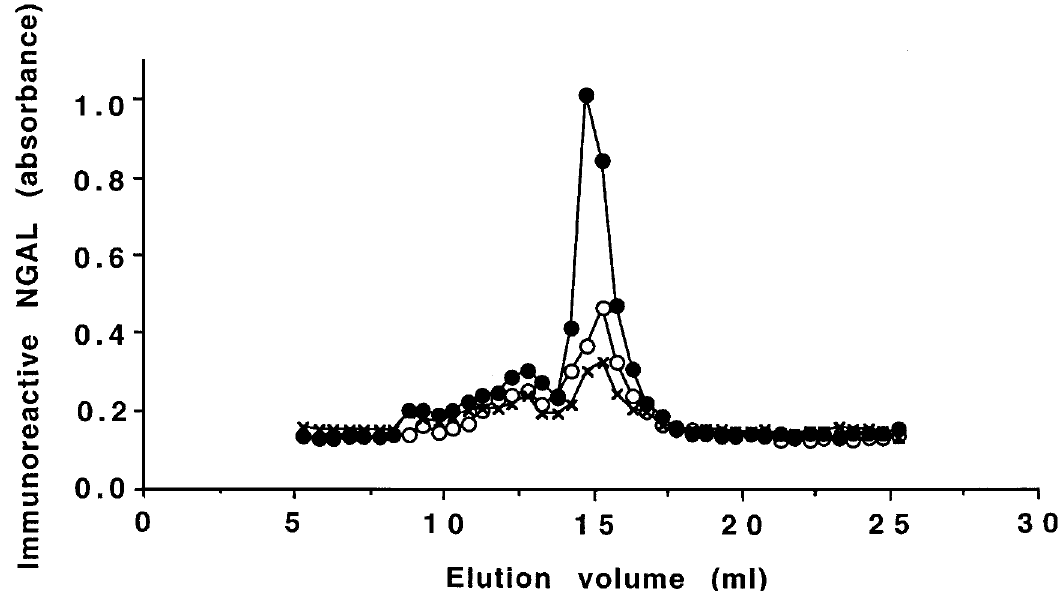
FIG. 2. Immunoreactive NGAL (measured as absorbance at 405nm) after separation on HPLC Superose 12. Patient sample after 3h ( d ) and postoperative day 1 ( 3 ) and in vitro activation ( s